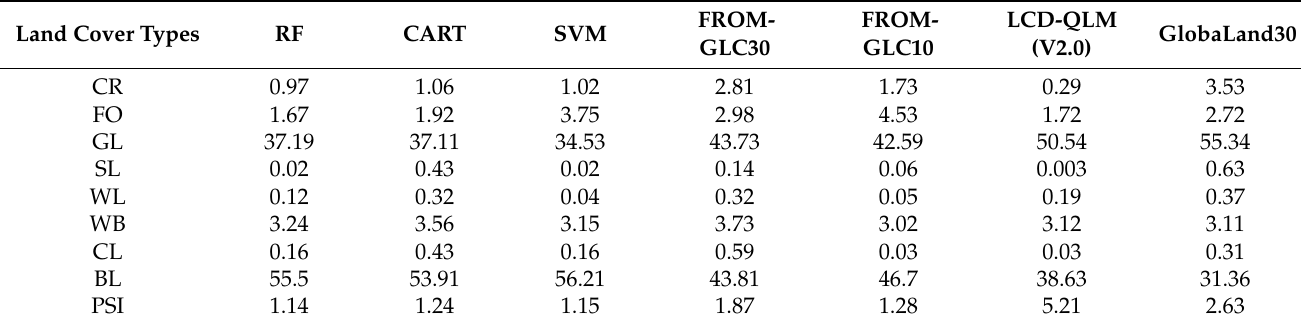
Table 4. Ratios (%) of different land cover type areas of different classification maps.